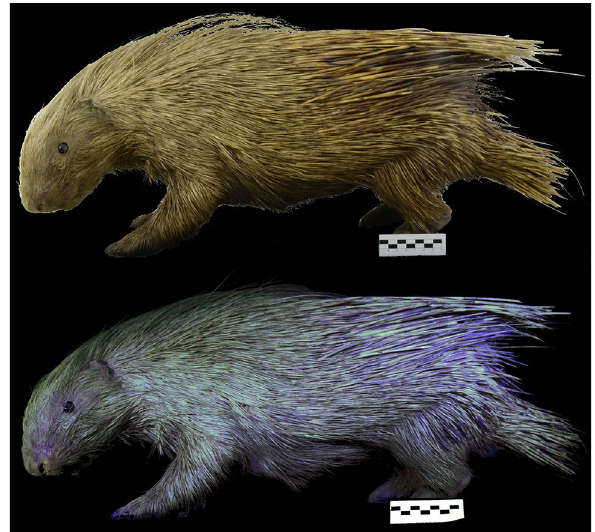
Figure 2. Photographs of Hystrix javanica (MN306) under visible light (top row) and 395 nm ultraviolet (UV) light (bottom row).